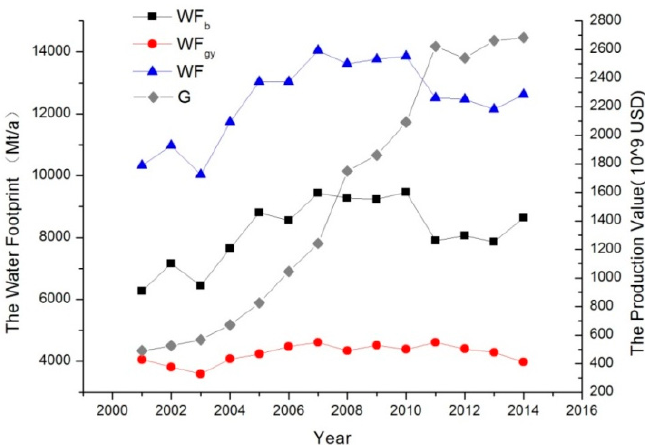
Figure 1. Changes in total output and water footprint (WF) of China’s textile industry (2001–2014). Note: WF b , blue water footprint; WF gy , grey water footprint; G , gross annual industrial output.